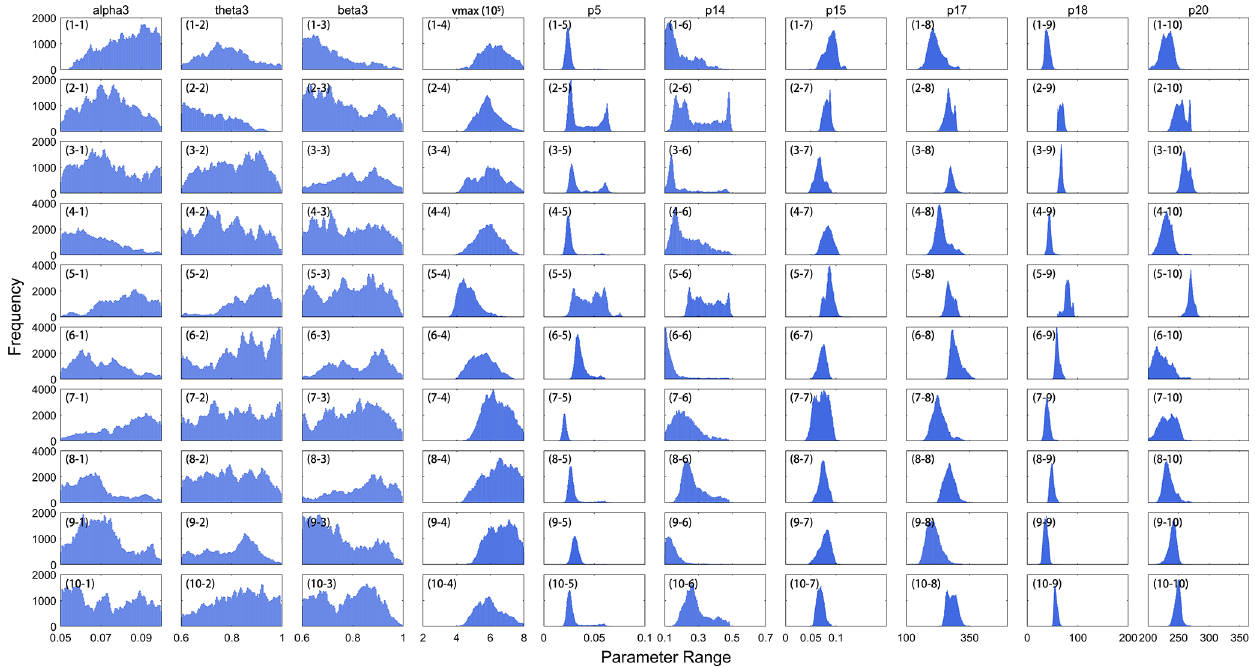
Figure 2. Posterior probability distribution of 10 representative samples.